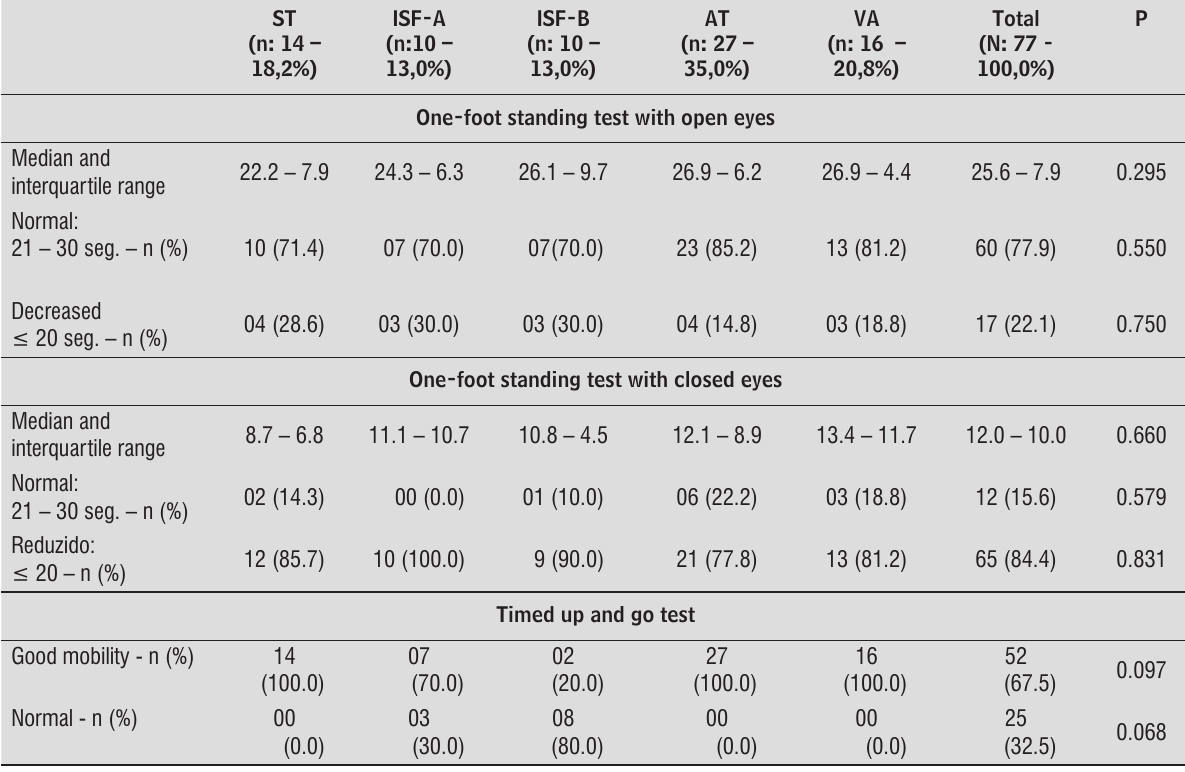
Table 3 – Results for the functional test one -foot standing, with open eyes and closed eyes, and time up and go for each